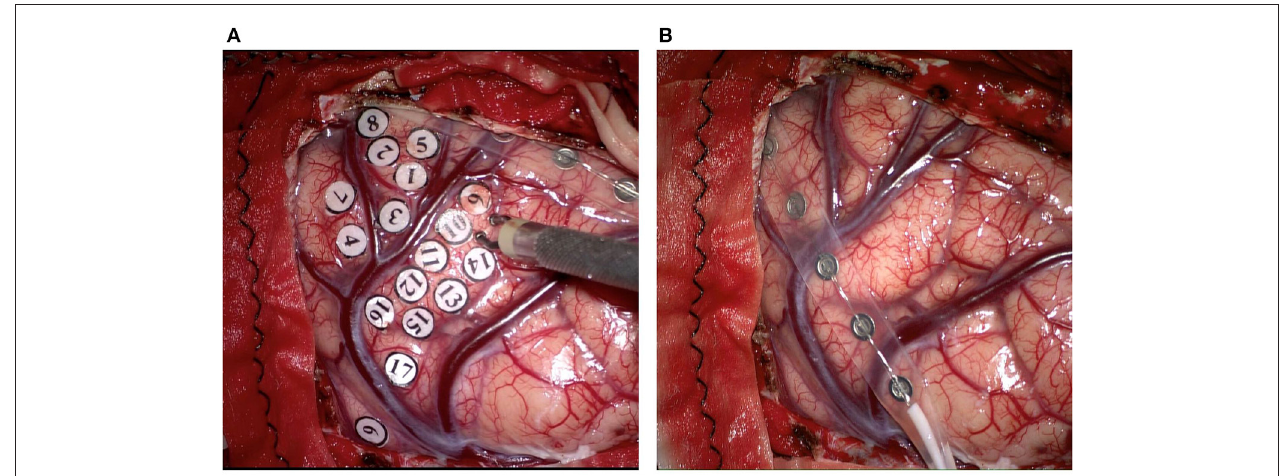
FIGURE 1 | The techniques applied for intraoperative direct electrical stimulation in resection of glioma. (A) The Ojemann cortical stimulator which is bipolar probe is applied for localizing eloquent areas to protect essential neurological function. (B) A grid electrode containing six electrodes is applied for localizing the central sulcus, and monitoring spontaneous and stimulus-like epileptiform waves in order to find and deal with the epilepsy foci related to